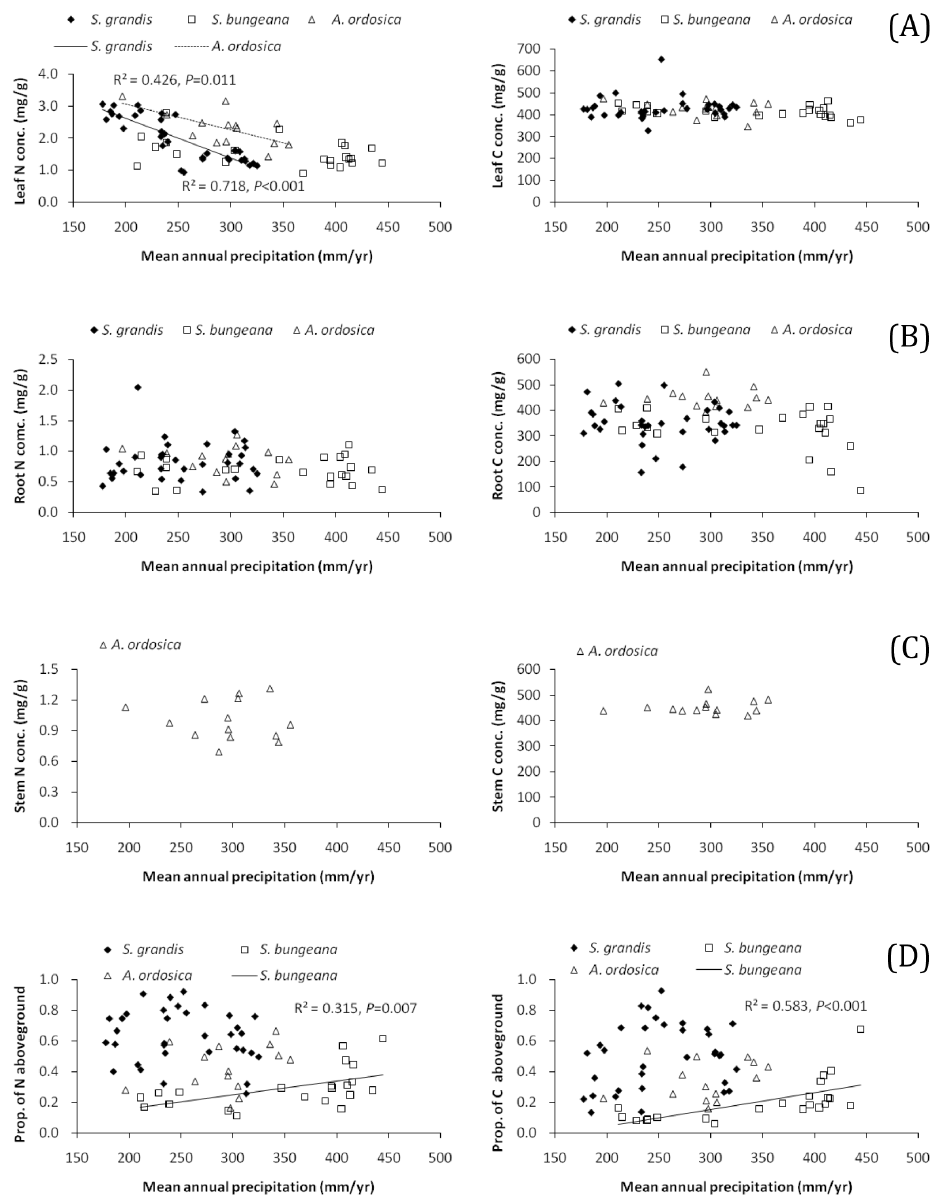
Figure 4. The relationship between mean annual precipitation and plant traits: (a) leaf nitrogen (LNC) and leaf carbon concentration (LCC), (b) root nitrogen (RNC) and root carbon concentration (RCC), (c) stem nitrogen (SNC) and stem carbon concentration (SCC), and (d) pro- portion of N and C